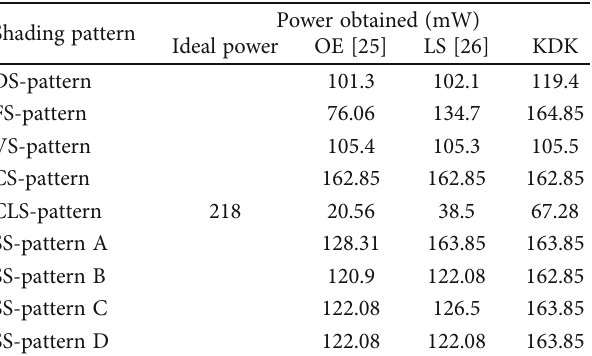
Table 5: Experimental